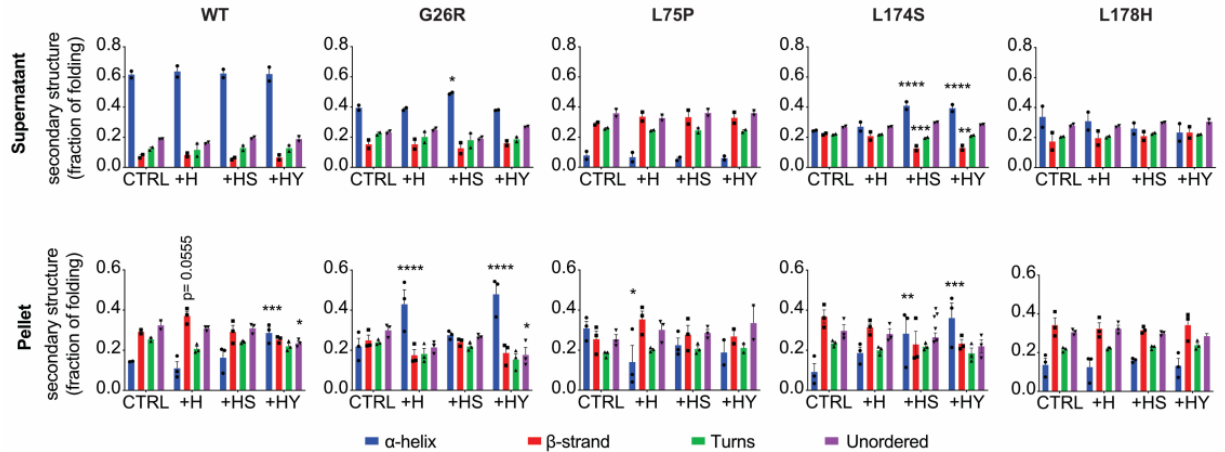
Figure 6. Secondary structure estimation of ApoA-I amyloidogenic variants in the presence of the different ECM components at pathophysiological pH. ApoA-I proteins (2 mg/mL) were incubated with the different ECM components (1:2 protein to ECM molar ratio) for one weeks in McIlvain buffer, pH 6.4, under agitation. At the end of the incubation, samples were centrifuged at 20,000 × g for 30 min at 4 °C and both the supernatant and the insoluble material were analyzed by SRCD. CDSSTR algorithm was used to estimate the secondary structure distribution of ApoA-I proteins in the supernatant (upper panels) and insoluble fraction (lower panels). H = heparin, HS = heparan sulfate, HY = hyaluronate. Significance was calculated according to two-way ANOVA (* p < 0.05, ** p < 0.005, *** p < 0.001, **** p < 0.0001 for groups as shown with respect to the control).